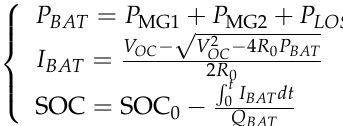
Figure 2. Optimal BSFC curve of the ICE.